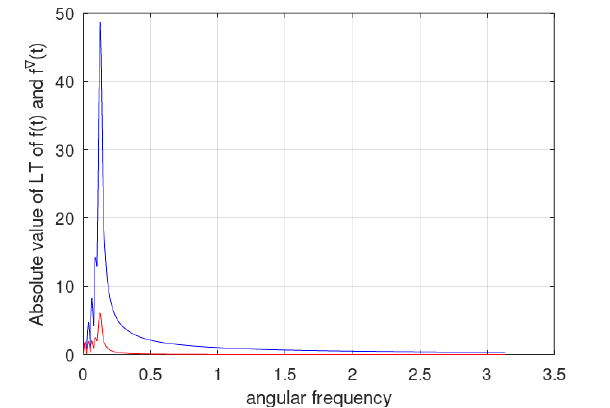
Figure 3. Transforms of the signals used in Example